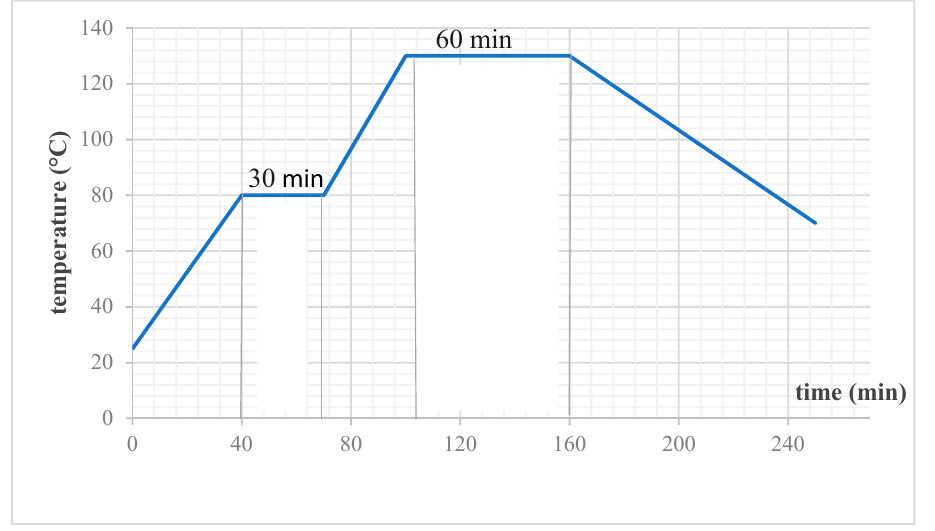
Figure 3. Post-curing cycle.